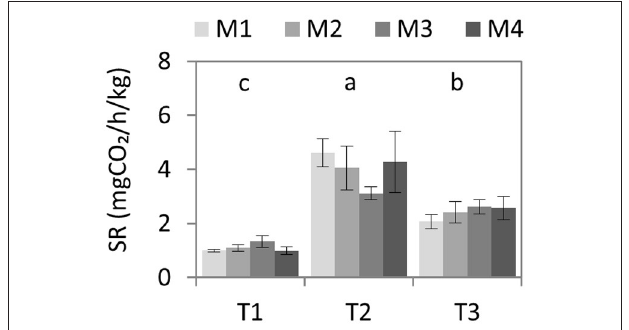
FIGURE 3 | Average values and standard errors of soil respiration rate (mgCO 2 /kg/h, dry weight) after 72h incubation time at 30 ◦ C. Values of the four biodisinfestation treatments (M1, M2, M3, M4) were measured at three different times: T1 (pre-treatment), T2 (post-treatment) and T3 (post-crop after treatment). No statistical differences ( P ≤ 0.05) were obtained among treatments. Letters indicate the significant differences among times according to Tukey HSD test ( P ≤ 0.05).